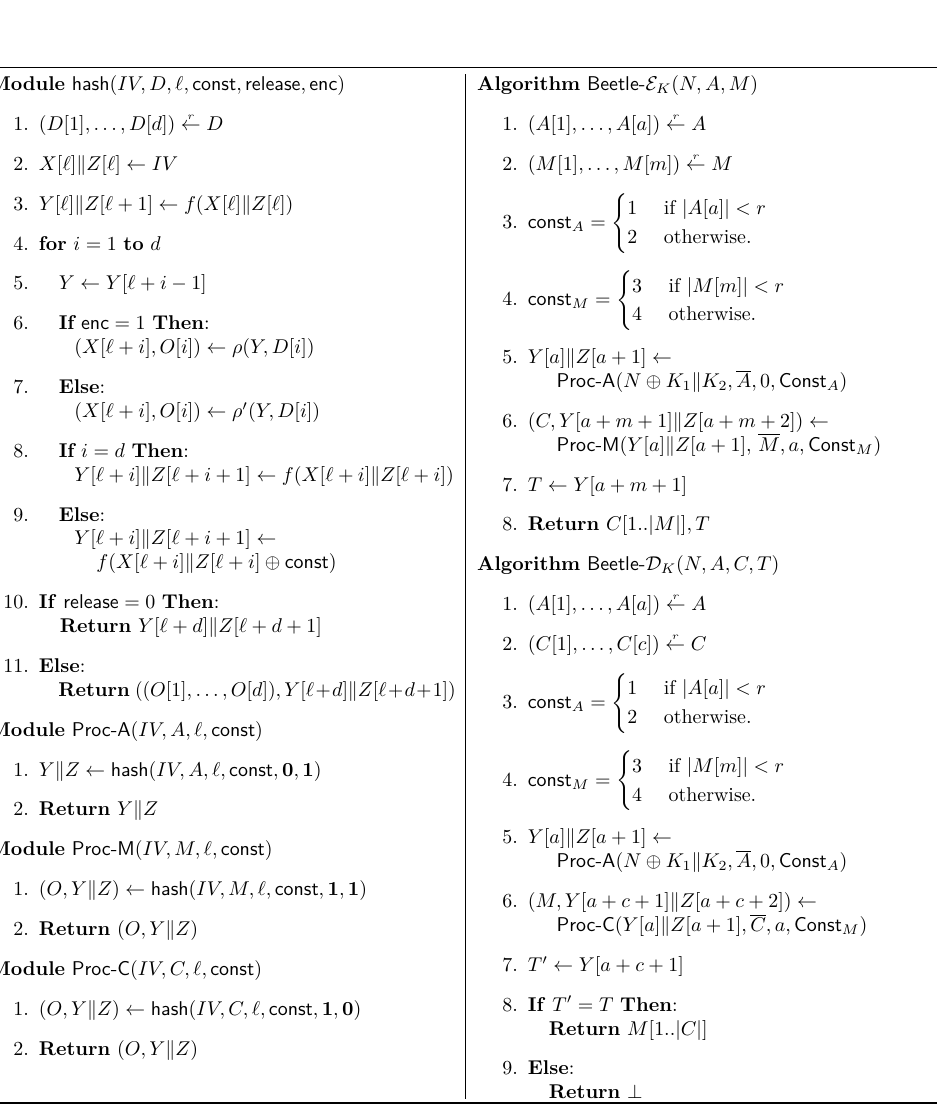
Figure 2: The encryption and decryption algorithms of Beetle . Here ∀ i, | X [ i ] | = | Y [ i ] | = | O [ i ] | = r and | Z [ i ] | = c